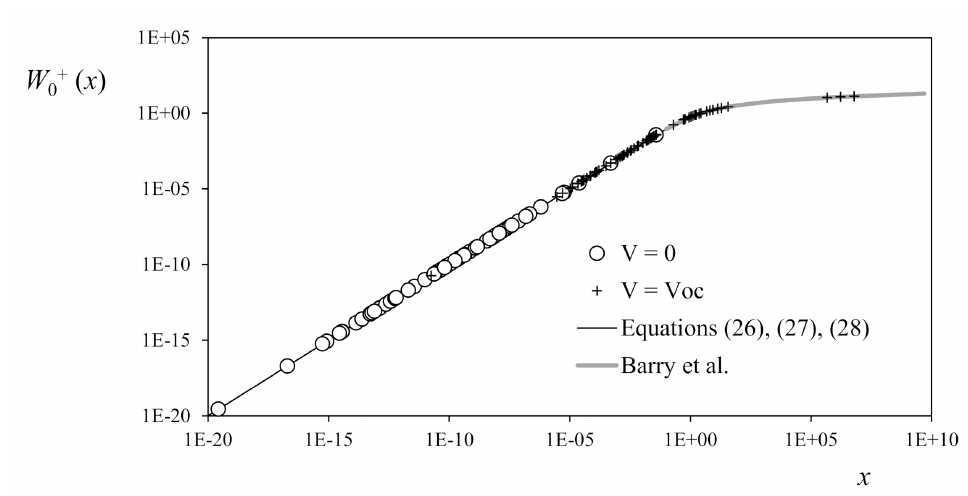
Figure 8. Positive branch of Lambert’s W-function (right-side), W 0+ , calculated at V = 0 and V = V oc for points x (Equation (25)) corresponding to the 1-D/2-R equivalent circuit model, based on the data for the solar cells/panels. Our approximation for W 0+ (Equation (26) to (28)) is also